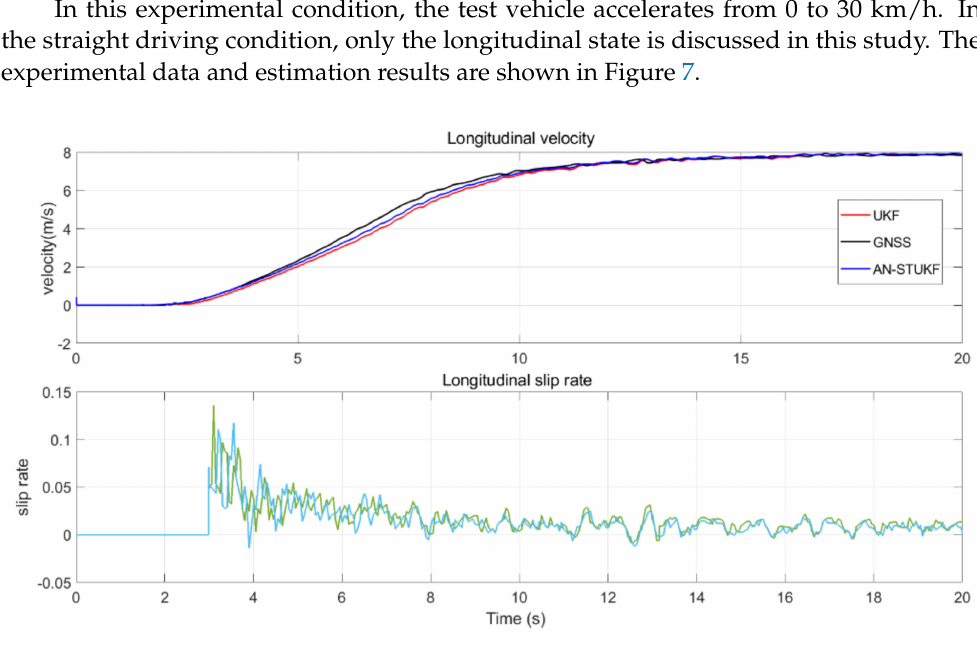
Figure 7. The longitudinal state when a skid-steered wheeled vehicle drives